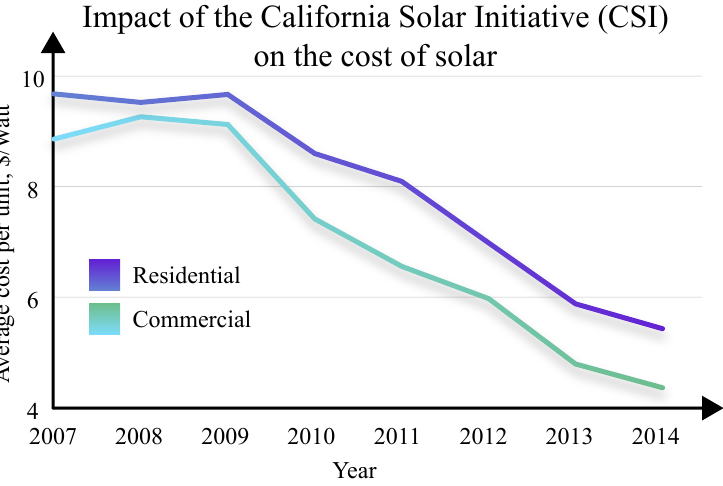
Figure 23. Massive success of California solar incentive (CSI) program in driving down the cost per watt of solar electricity by 45% in the residential sector and 51% in the commercial sector [98]. The million roofs target was reached in 2014, which is why the cost reduction has been plotted up to 2014. Further cost reductions are not directly associated with